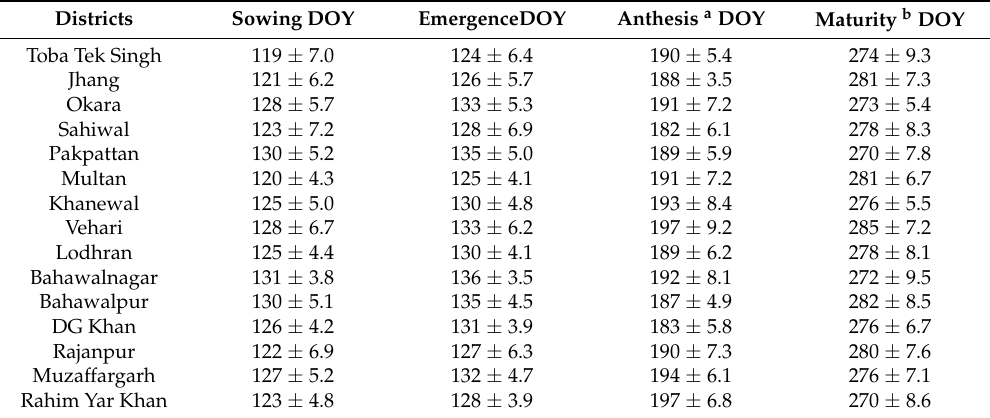
Table 1. Average observed phenology of cotton in Punjab, Pakistan, during the period of 1980–2015.